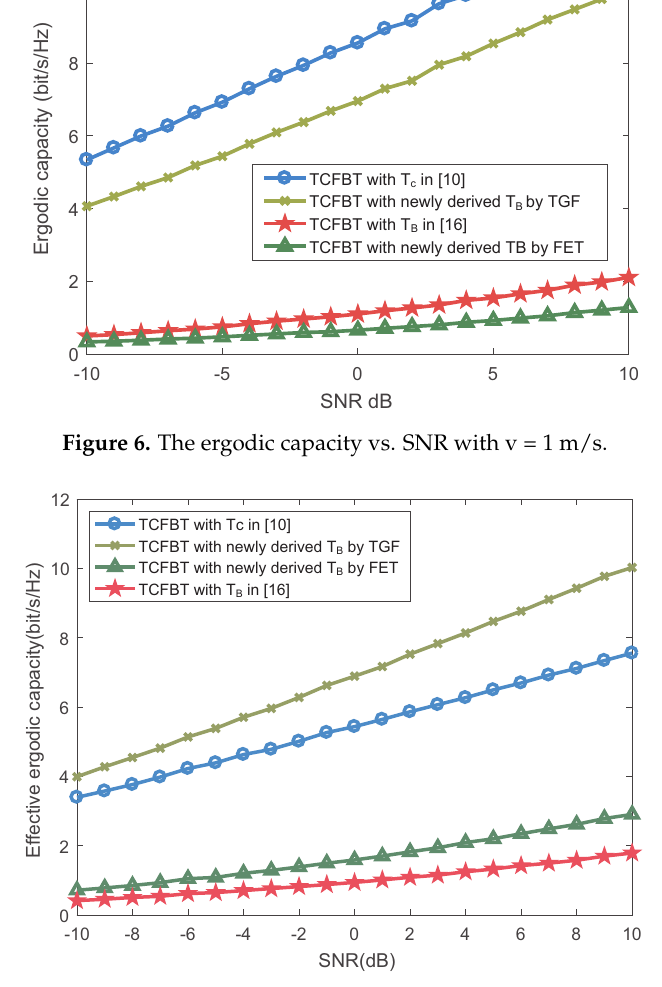
Figure 7. The effective ergodic capacity vs. SNR with v = 1 m/s and OFDM duration = 8.92 us